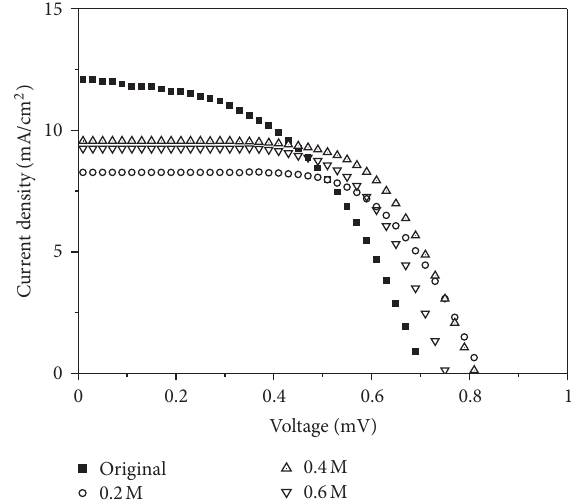
F 5: Photovoltaic curves ( J - V ) of the DSSC based on the composite electrolytes with 1-butyl-3-methyl-imidazolium chloride at different